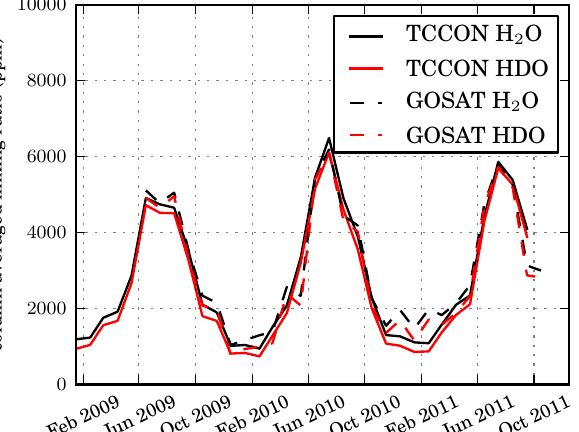
TCCON station with overlap from June 2009 through September 2011. Even though water vapor is highly vari- able and the coincidence criterion ( ± 2 ◦ ) is not very stringent, the overall seasonal cycle shape and the inter-annual vari- ability are consistent. The measurements show peaks in mid- summer and overall higher column amounts in 2010 than in 2009 or 2011.